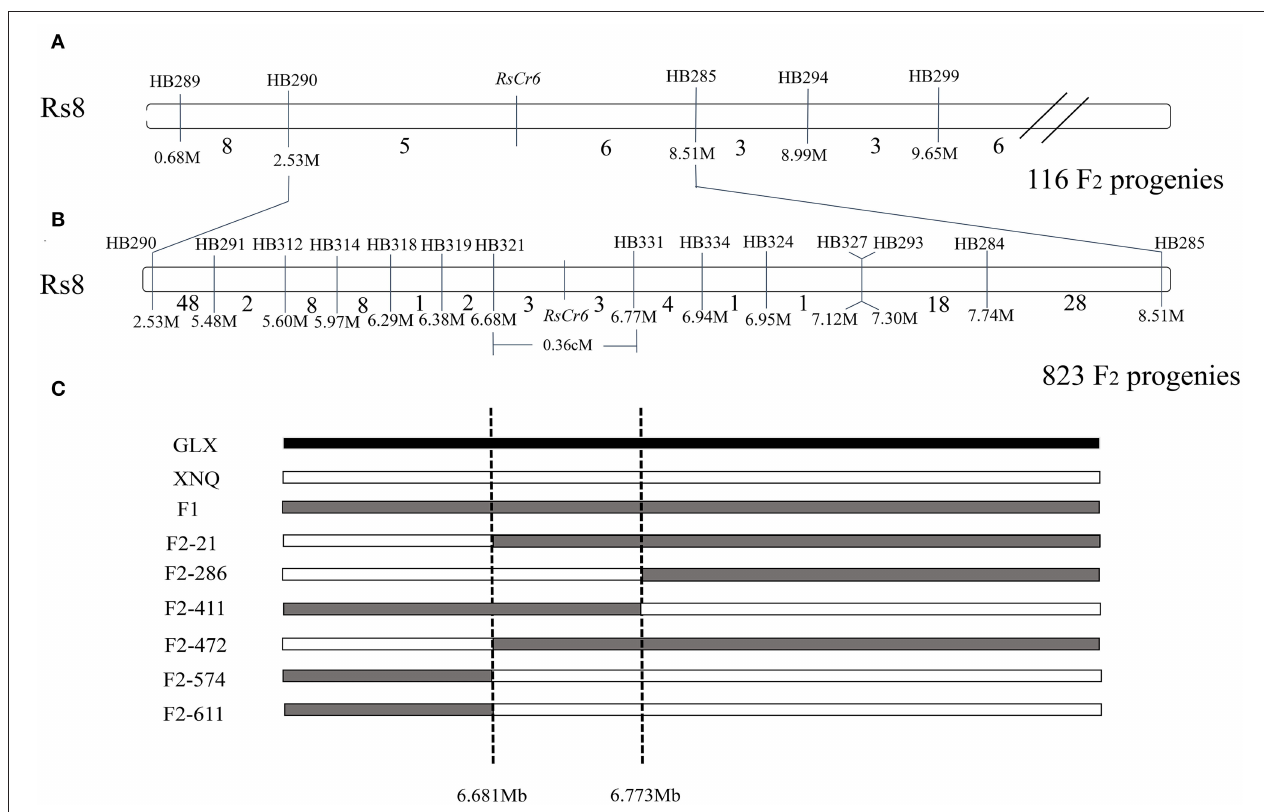
FIGURE 3 | Mapping of clubroot resistance gene RsCr6 . (A) Preliminary mapping of RsCr6 between molecular markers HB290 and HB285 using 116 F 2 individuals. (B) Fine mapping of RsCr6 between molecular markers HB321 and HB331 using 823 F 2 individuals. The numbers between adjacent markers represent the number of recombinants. The numbers below marker names represent the physical position for corresponding markers. (C) Diagram of recombinants in a narrow interval between markers HB321 and HB331. “M” and “Mb” represent million bases; and genetic distance is showed in cM.